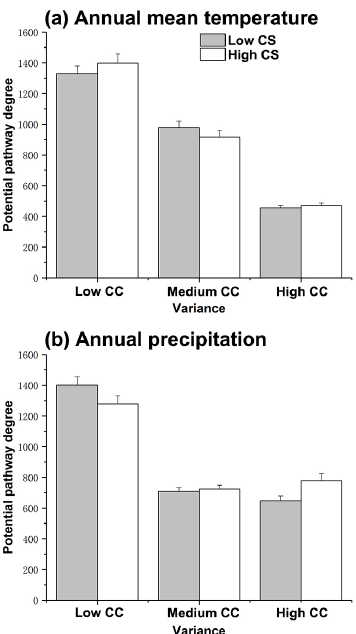
Figure 3. Ranges of potential pathways for invasive plant species (IPS) in protected areas under climate change. CC is the degree of variation of climate change. CS is the gas concentration scenario. Bars represent standard error; vertical axes represent the extent of potential pathway degrees for IPS in protected